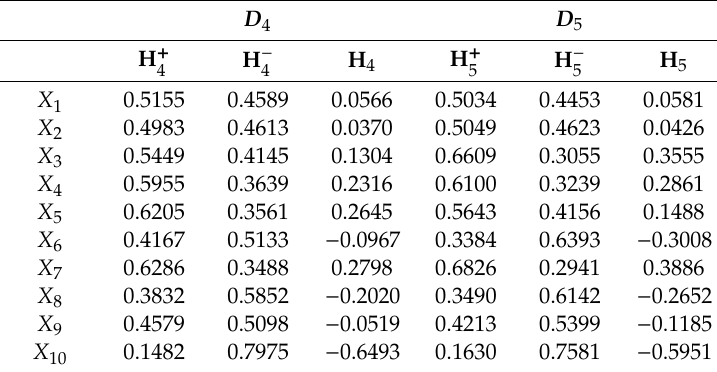
Table 7. The positive, negative and net flow of X v for D 4 , D 5 .